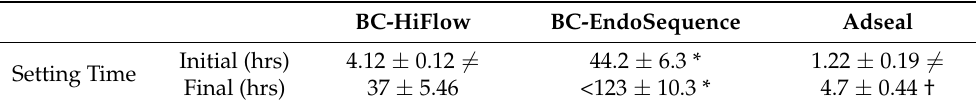
Table 1. Represents the means ± Standard deviation values of initial and final setting times of the three tested